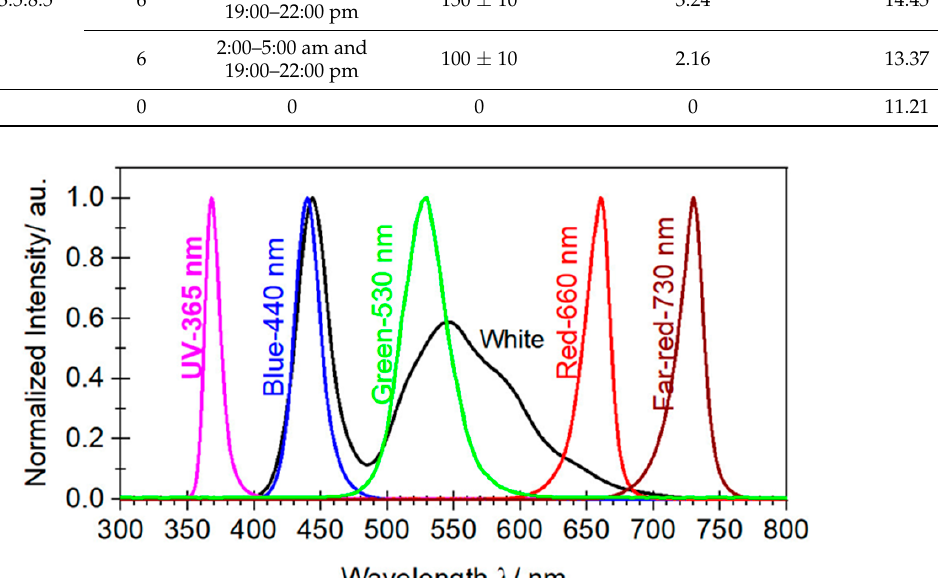
Figure 1. Normalized spectral distribution of supplemental LEDs lighting. Each basil sample was determined the water content using A&D Weighing AD-4714A General purpose moisture determination